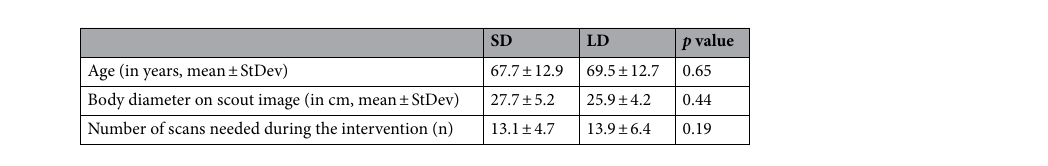
Table 3. Cohort and procedure